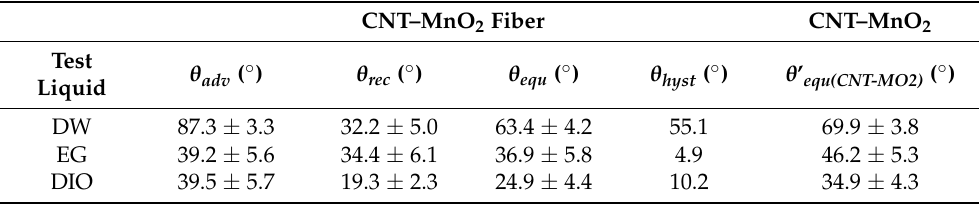
Table 2. Advancing, receding, and equilibrium contact angles measured for DW, EG, and DIO. Equilibrium contact angles of the solid CNT–MnO 2 fiber (10, 8) ( θ ’ equ(CNT-MO2) ) were calculated by using the modified Cassie–Baxter